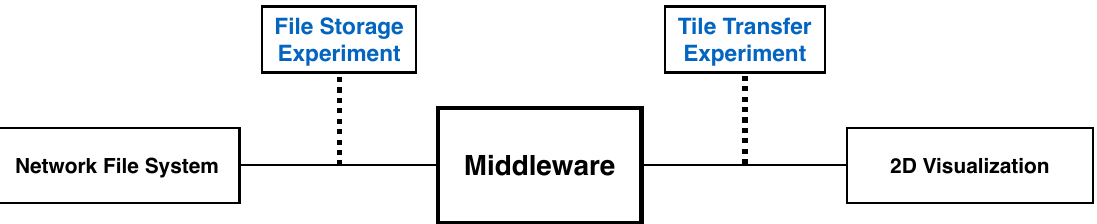
Figure 10. We record throughput of a generalized scalable visualization pipeline, to inform best-practice Butterfly parameter settings. This pipeline replicates the general setup of all reported 2D visualization tools. First, we load data from a network file system. Our middleware then processes these files and transfers tiled images to a 2D visualizer. Our experiments include the file storage experiment and the tile transfer experiment